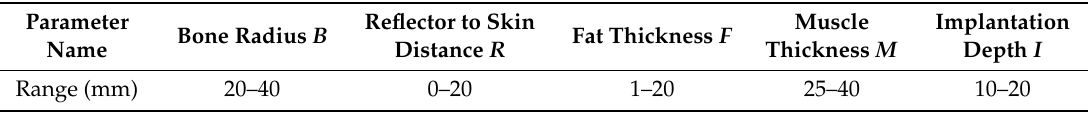
Table 3. The ranges for the 5 analyzed